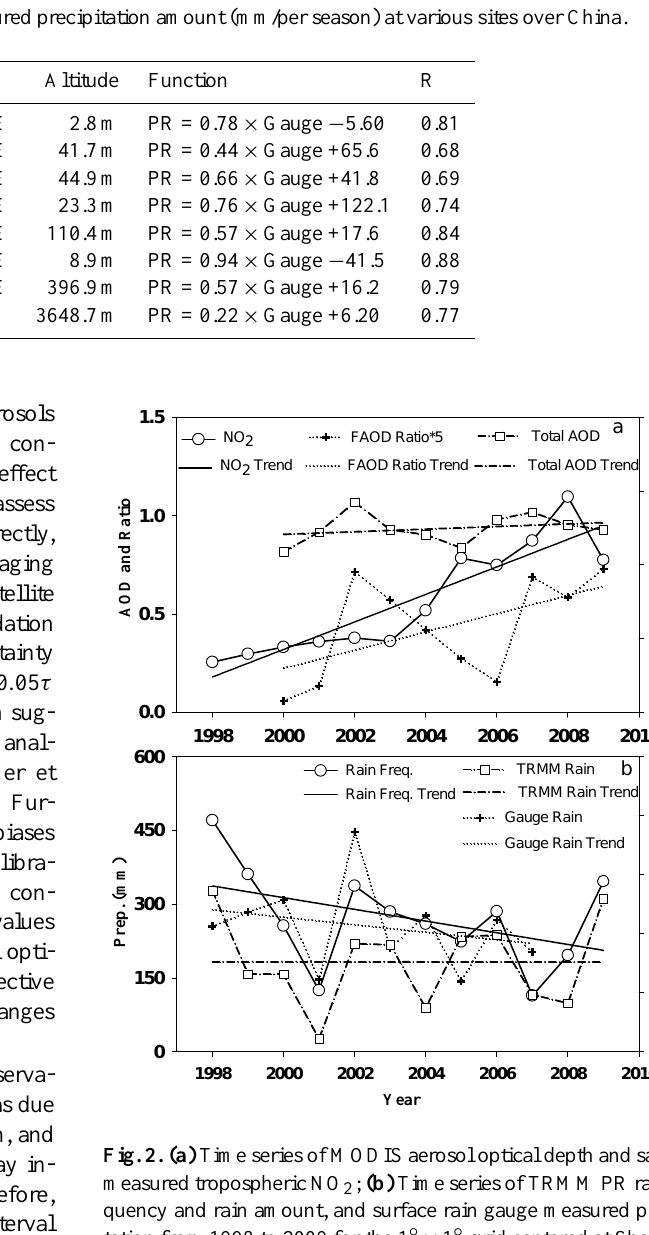
boundary layer and at the source (Richter et al., 2005). As shown in Fig. 2a, satellite retrieved NO 2 column concen- tration in spring in Shanghai increased substantially from 1998 to 2009. The linear trend in NO 2 column concen- tration is 1.6 × 10 15 molec cm − 2 per year. With respect to the reference value of 6.8 × 10 15 molec cm 2 in spring 1998, air pollution in Shanghai was almost tripled from 1998 to 2009. Nitrogen dioxide is an effective absorber of visible and near-ultraviolet solar radiation. At wavelengths below ∼ 400 nm, photodissociation of NO 2 generates NO and